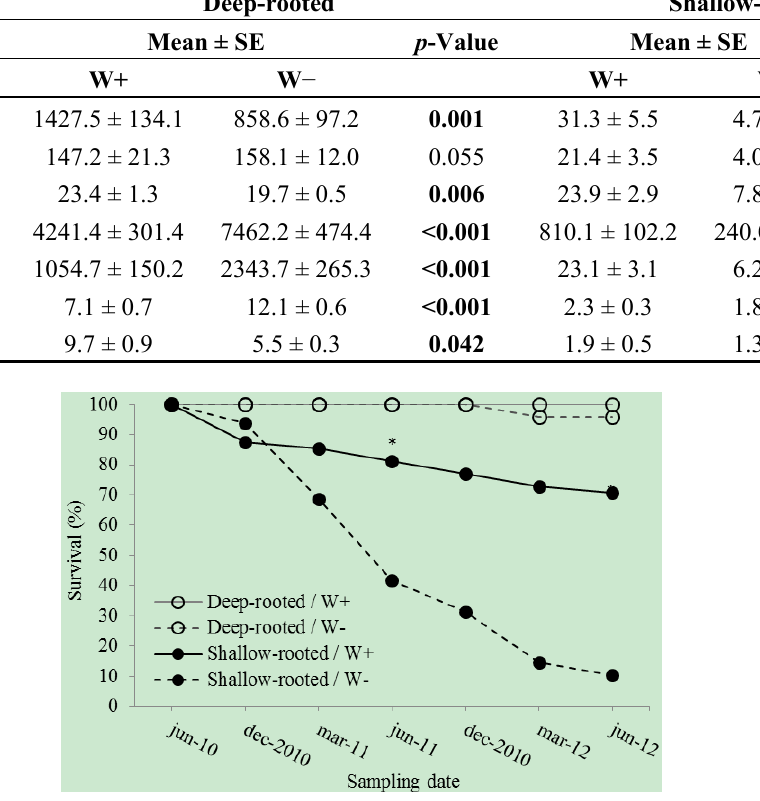
Figure 2. Survival (%) of deep-rooted ( Q. saponaria , white circles) and shallow-rooted ( C. alba , black circles) species growing in the field under different water availability treatments (W+: solid line; W−: dashed line). Each point is the percentage of saplings remaining alive out of 48 planted initially in June 2010 (Deep-rooted species W+ and W−: final n = 48 and 46 saplings, respectively; Shallow-rooted species W+ and W−: final n = 34 and 5 saplings, respectively). Asterisks indicate significant statistical differences at p < 0.05 (Chi-Square test) between W+ and W− treatments of saplings with the shallow-rooted